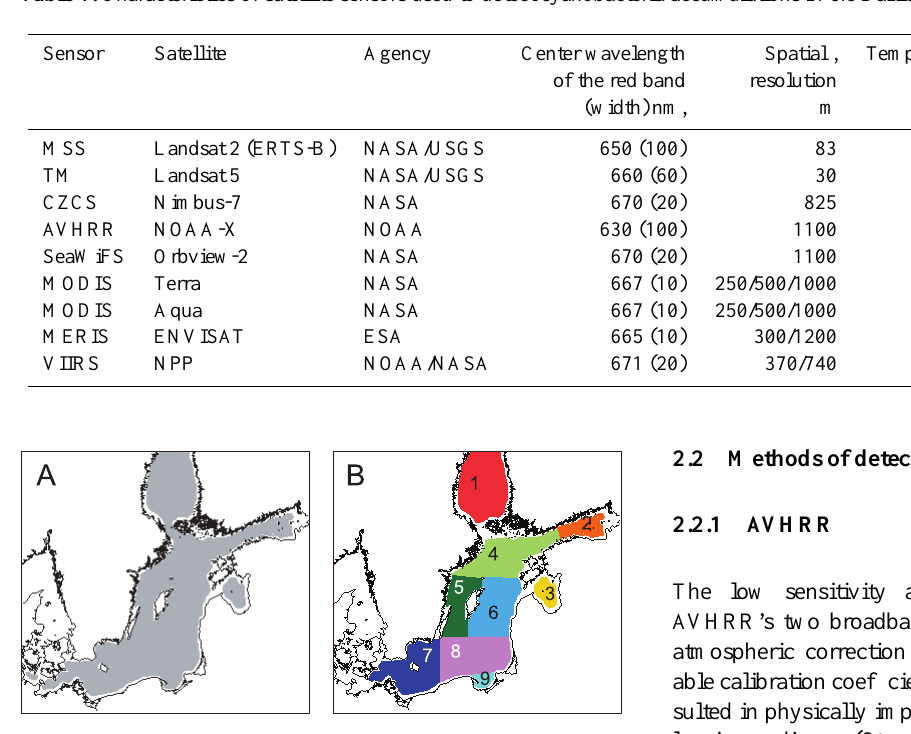
Figure 2. Study areas in the Baltic Sea. (A) The area considered (grey) in mapping cyanobacteria blooms excludes near-shore areas with potentially high turbidity (white, 19.5% of the total sea area).